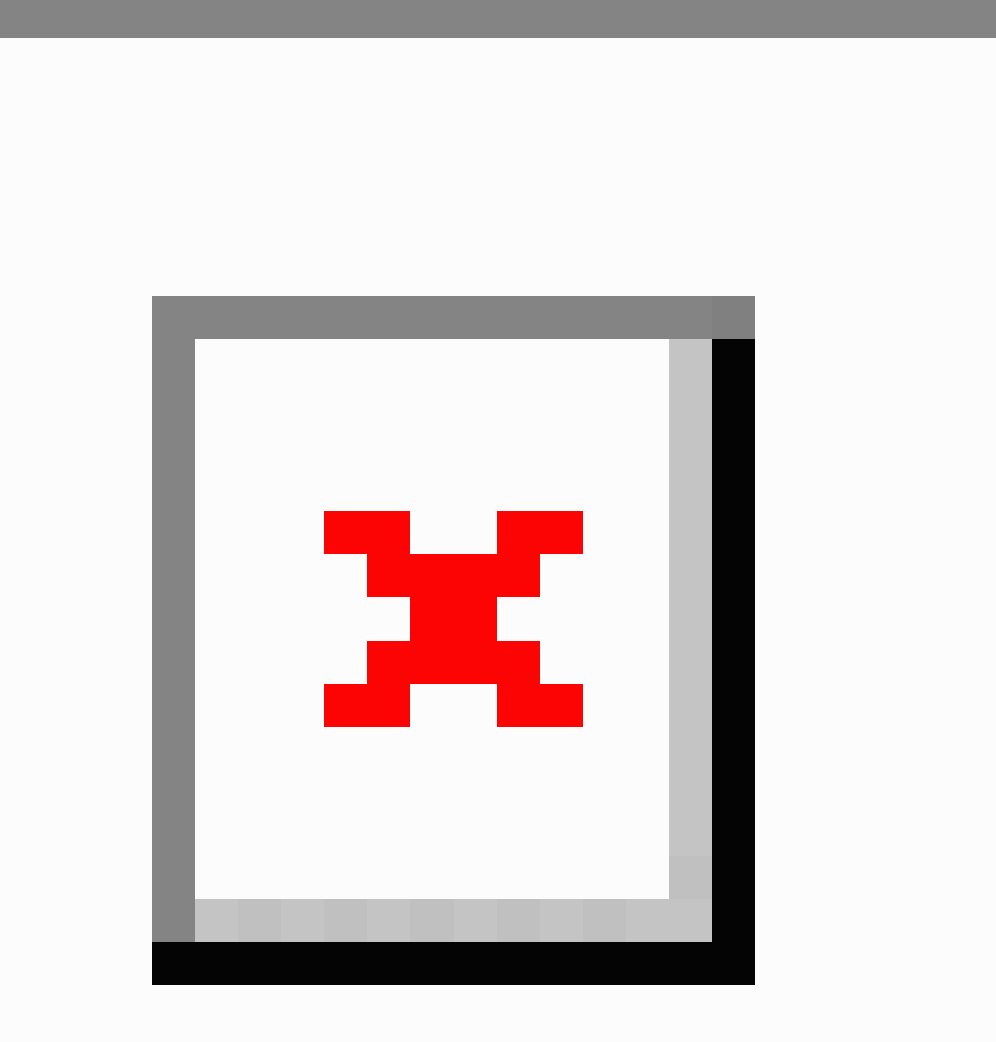
Figure 3. The daily posted and forwarded number of H7N9 discussion trends on Sina microblog positively associated with cumulative case fatality rate of human H7N9 infection in China from March 31 to April 24,